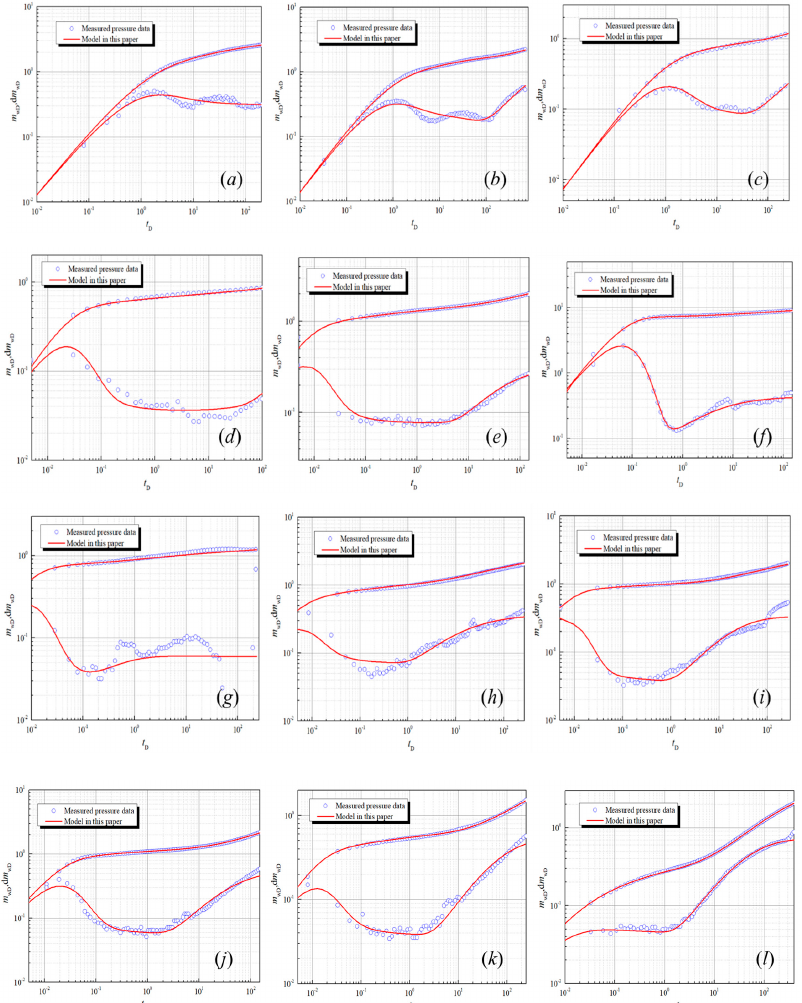
Figure 9. Pressure behaviors of typical wells with different injection − withdrawal periods: ( a ) to ( c ) refer to well H17 in 2nd, 3rd, and 4th gas injection cycles; ( d ) to ( f ) is the well H5 in the 4th, 5 th , and 6th gas injection cycles; ( g ) to ( i ) is the well H9 in the 1st, 5th, and 6th gas production cycles; and ( j ) to ( l ) is the well H22 in the 3rd, 4th, and 6th gas production cycles.